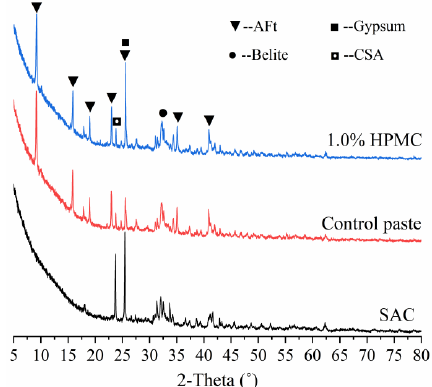
Figure 1. XRD patterns of SAC, control SAC paste and 1.0% HPMC SAC paste with W/C ratio of 0.40 at hydration time of 1 h.